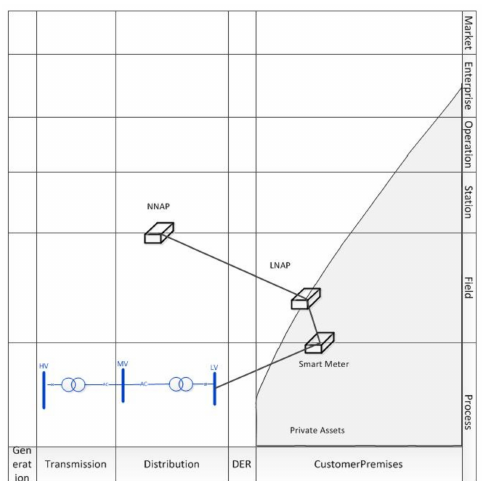
Figure 3. Use Case representation on the component layer.